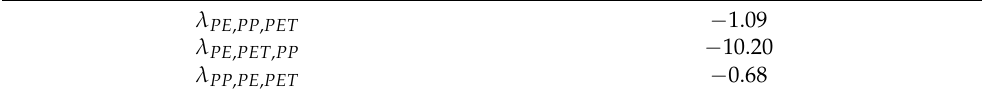
Table 2. Spreading coefficients (in mN/m) of the polymer triplets.